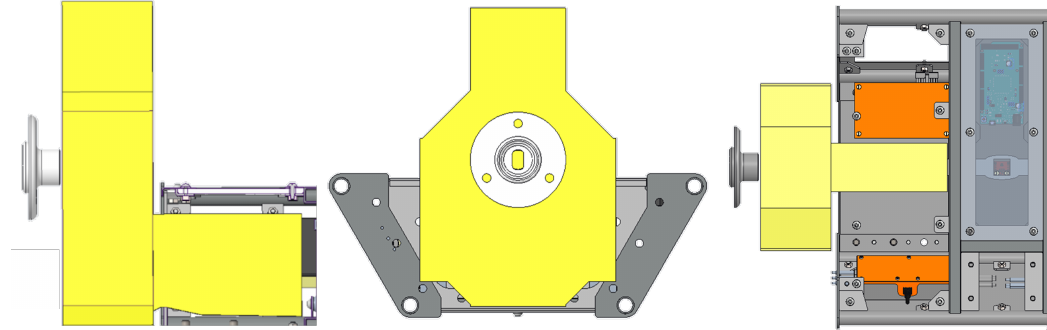
Figure 15. Space Model for the drivetrain view form front, side and above.